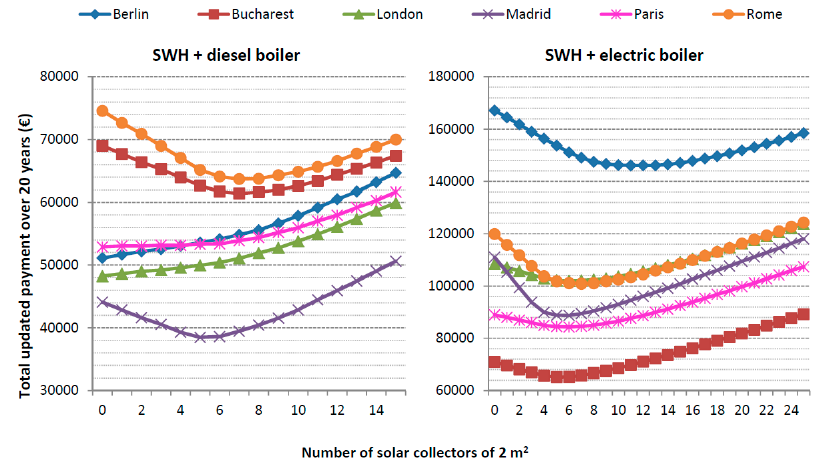
Figure 8. Total energy cost (including installation) over 20 years in the building of 10 homes, depending on the number of solar collectors installed and the type of conventional supply (diesel boiler and electric boiler).